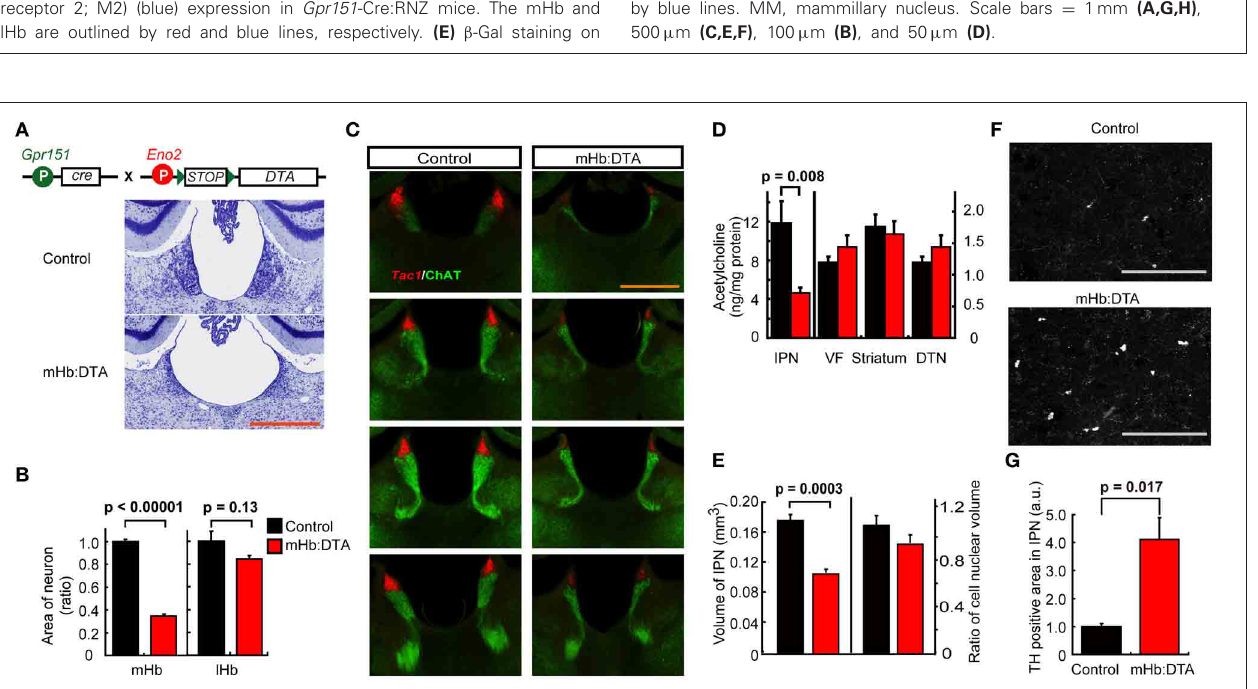
FIGURE 2 | mHb-selective lesions in mHb:DTA mice. (A) Neurons visualized by Nissl staining in the mHb and lHb of control and mHb:DTA mice. (B) Relative areas of Nissl stained neurons in the mHb and lHb of control and mHb:DTA mice (mice were 7–8 months old, n = 5/group, t -test). (C) Expression pattern of Tac1 (tachykinin 1, substance P) mRNA (red) and ChAT protein (green) in control and mHb:DTA mice at 3–4 months.